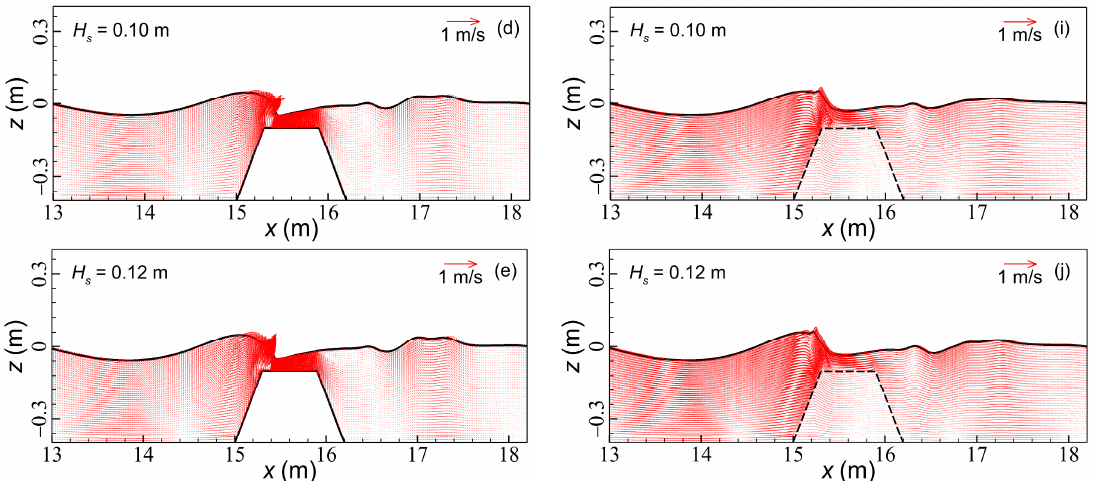
Figure 13. Comparisons of the snapshots of the vector velocity field around the submerged breakwater with different significant wave heights; left side ( a – e ): submerged impermeable breakwater; right side ( f – j ): submerged permeable breakwater.